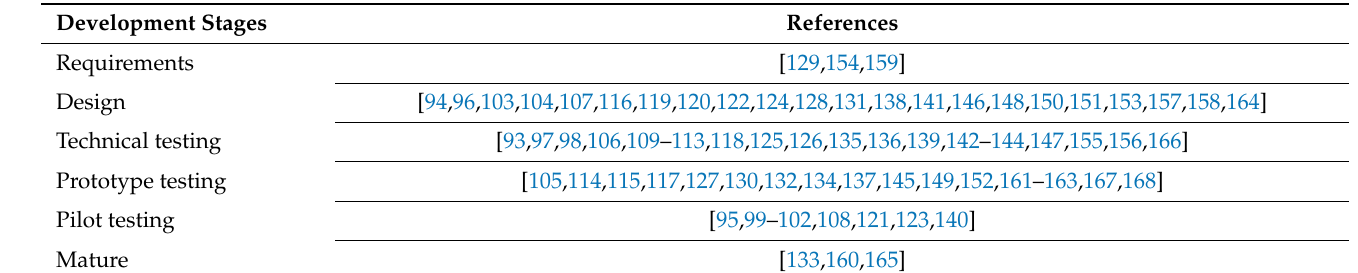
Table 4. Development stages the proposed